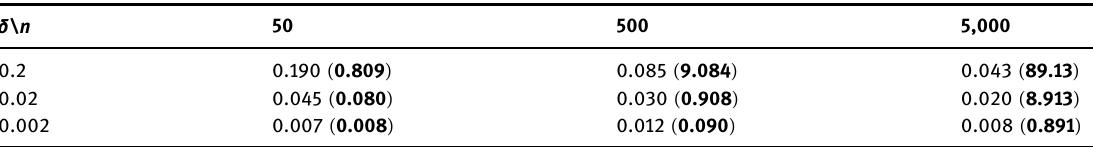
Table 1: l 2 - relative errors in the estimated derivatives for Example 5.1 for several sample sizes n and noise levels δ . Numbers in parenthesis represent the relative errors computed from the noisy data